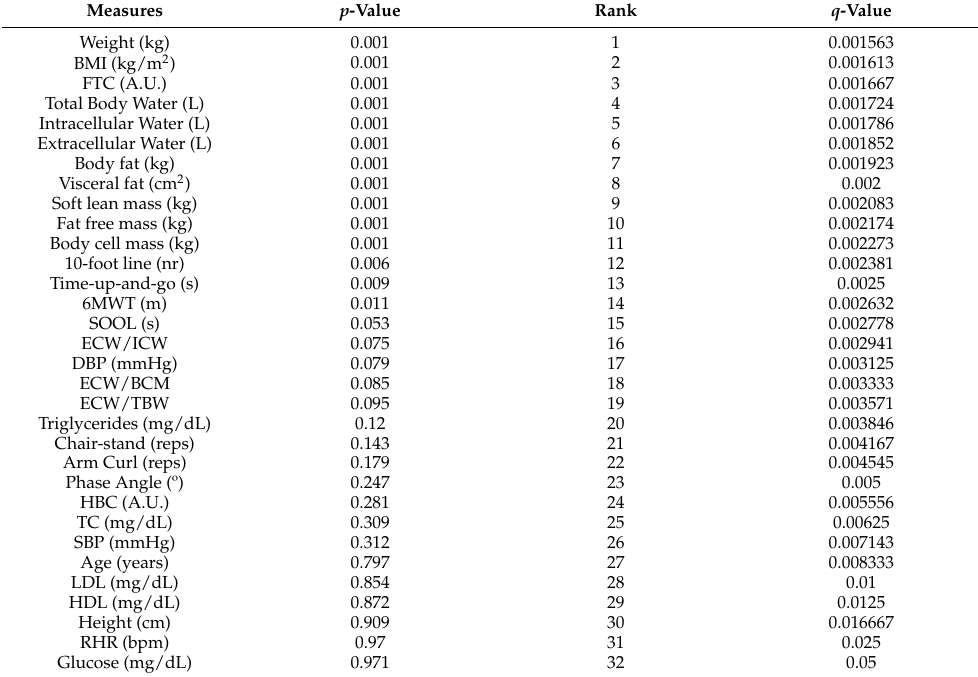
Table A1. Benjamini-Hochberg false rate discovery procedure for comparisons between